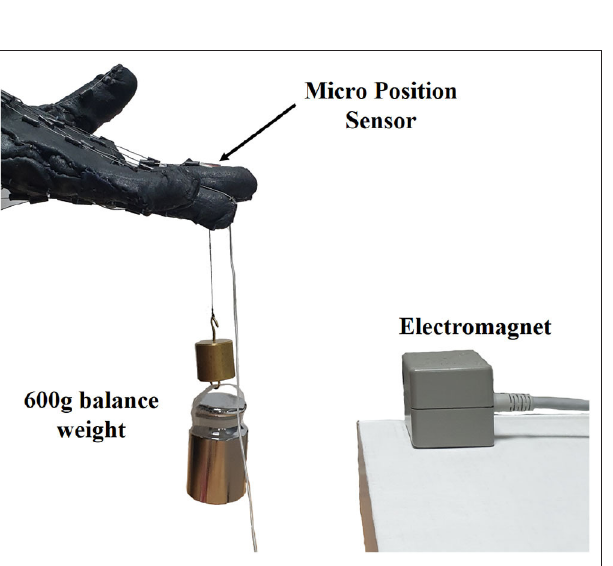
FIGURE 13 | Measurement setup for the nominal stiffness of the three conditions—low, high, and high-torque precision grip conditions. A high-resolution electromagnetic sensor attached to the index fingertip measured the displacement of the fingertip by 600 g of balance-weight.